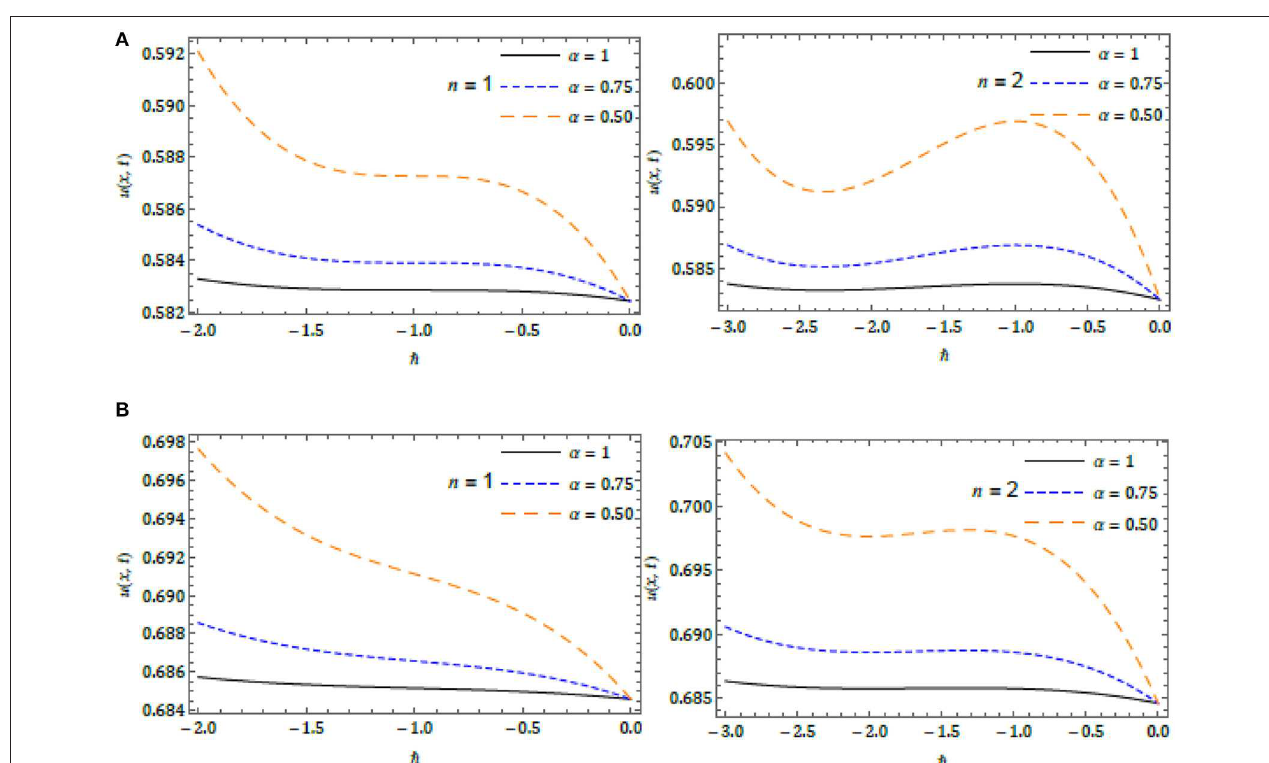
FIGURE 4 | ℏ -curves for (A) Case 1 (B) Case 2 with distinct α at x = 1 and t = 0.01 with n = 1 and 2.